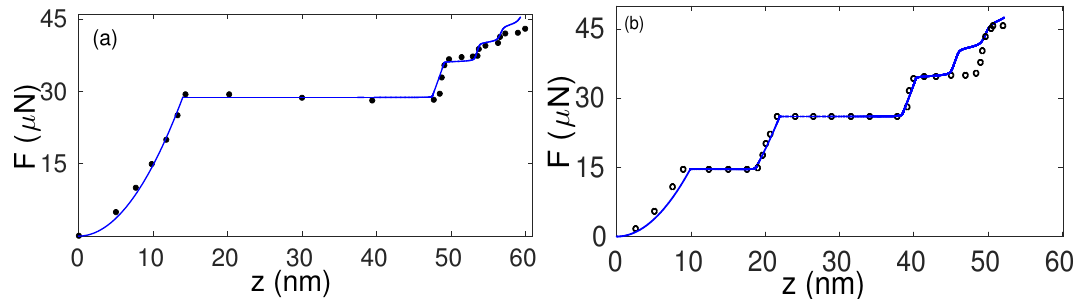
Figure 7. ( a ) plot of model F − z curve (continuous curve) for Al single crystal of ( 110 ) orientation along with experimental points ( • ) extracted from Ref. [12], after [29]; ( b ) plot of F − z curve (continuous curve) t for Al single crystal of ( 133 ) orientation along with experimental points ( • ) [12]. Original contribution of the authors.